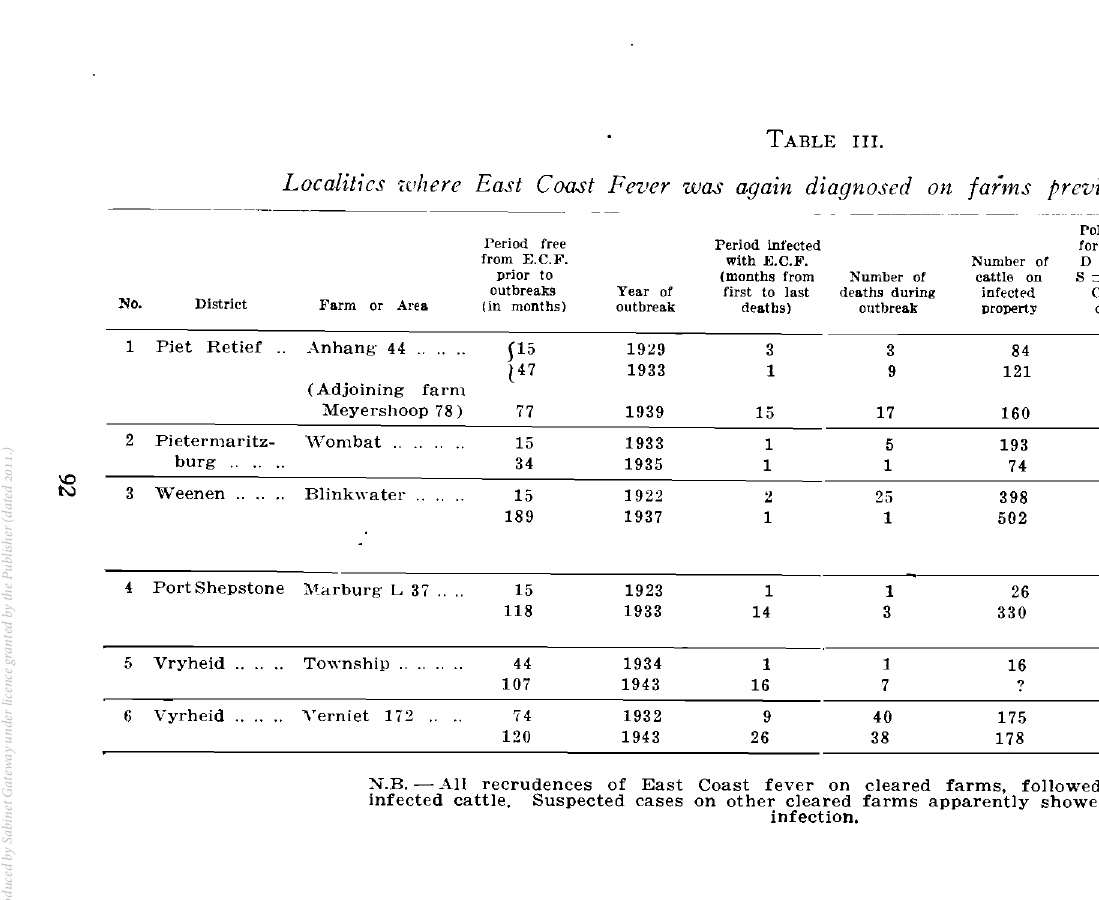
Localities where East Coast F n'er was agam diagnosed on farms previously cleared of cattle. Period free Period infected for eradication from E.C.F. with E.C.h'. Number of D prior to (months from Number of ca.ttle on S == Slaughter; outbreaks Year of first to last dea.ths during infected C == Farm To]X)grapby and